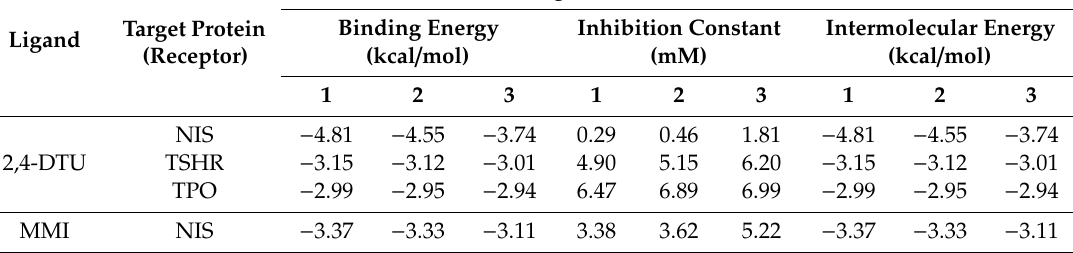
Table 4. The obtained docking parameters of the 2,4-dithiouracil molecule on their rank calculated by Autodock.